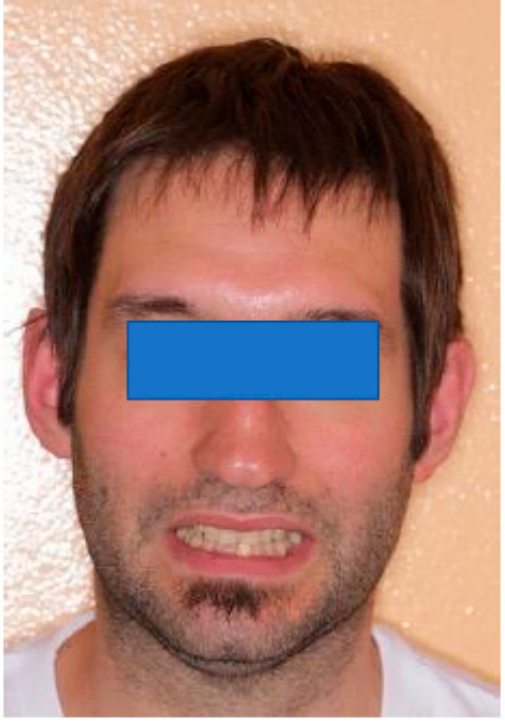
Figure 24. Extraoral examination reveals upper and lower midlines deviated 1 mm to the right from the midline of the face, with a disharmonious smile.